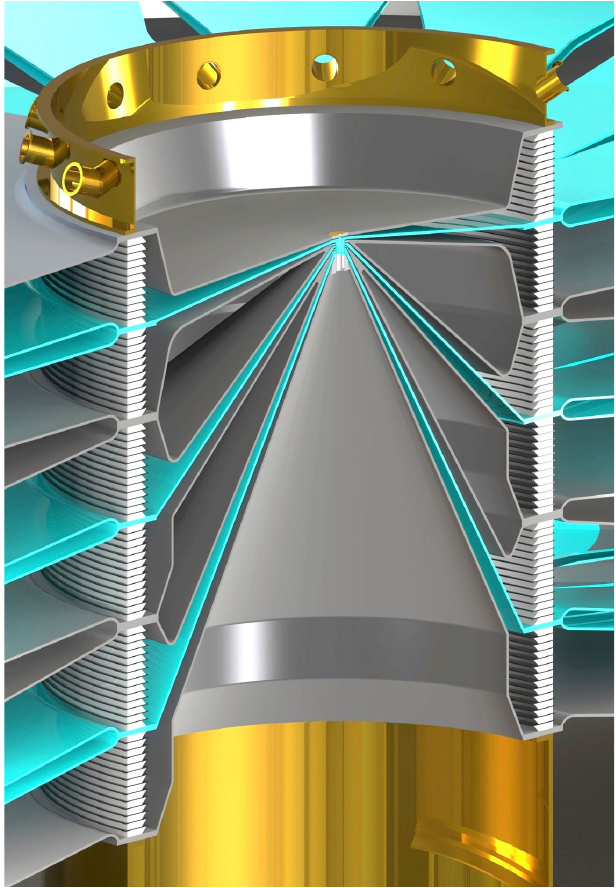
FIG. 12. Cross-sectional view of the centrally located vacuum section of Z 800. This section includes six water flares, six vacuum insulator stacks, six vacuum flares, and six conical MITLs. The six levels of the system are electrically in parallel. The outer radius of the stack is 2.65